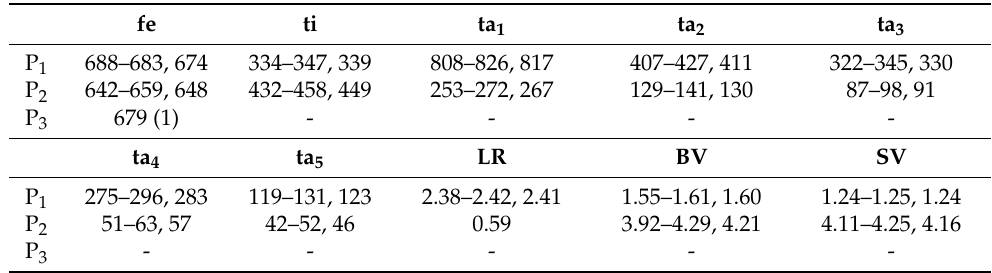
Table 1. Lengths (in µ m) and proportions of legs of Rheotanytarsus falcipedius Kyerematen, Andersen & Sæther, 2000, adult male ( n =